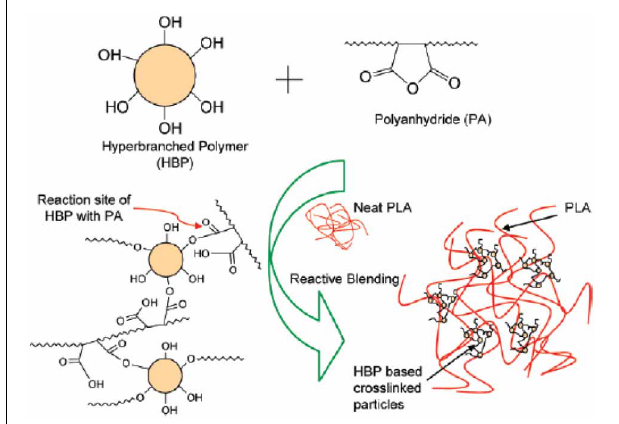
FIGURE 15 | Schematic illustrations of in-situ cross-linking of hyperbranched polymer (HBP) in the PLA melt with the help of a polyanhydride (PA). Adapted with permission from Bhardwaj and Mohanty (2007).